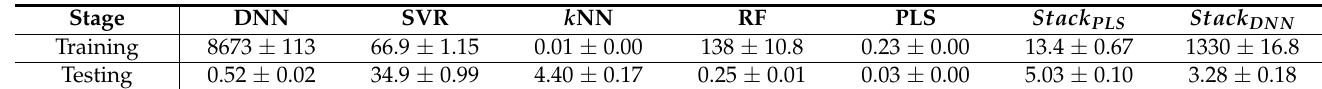
Table 3. Running times (in seconds) for the training and testing stages of the employed ML models. The time was measured for 6 runs, the average time over these 6 runs is presented as well the 95% confidence